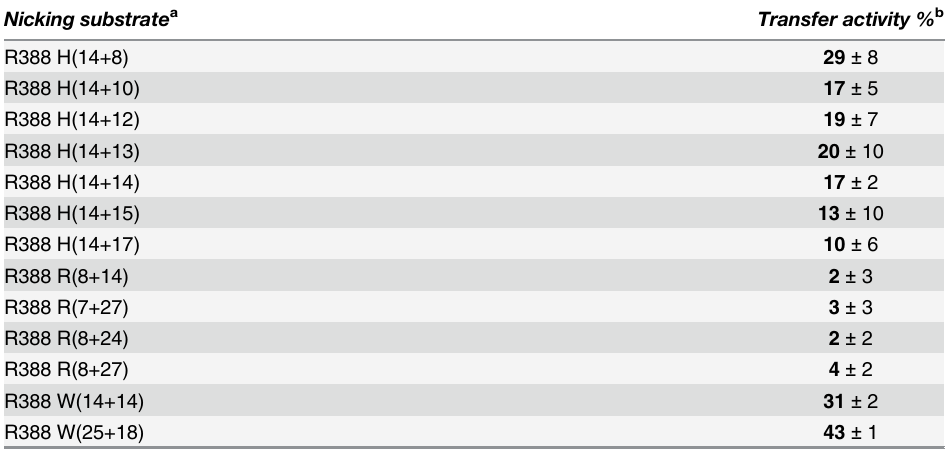
Table 2. Strand transfer reaction catalyzed by TrwC R of oligonucleotides with the Rep-like and Reverse-like layout to the W(25+0) oligonucleotide. Nicking substrate a